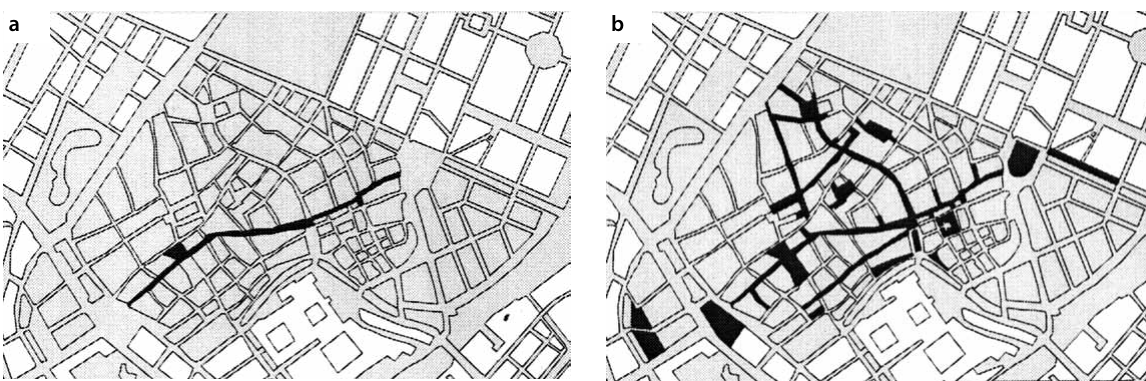
Fig. 1. Schemes of development and expansion of pedestrian areas in Copenhagen: a – in 1962 there was only one pedestrian street which occupied 15 800 m 2 ; b – in 1996 an entire pedestrian zone which occupied an area of 95 750 m 2 was